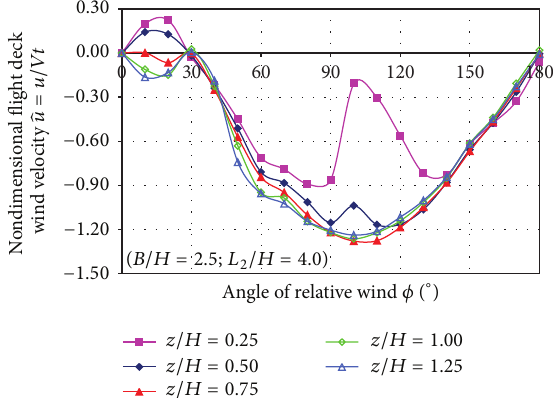
Figure 11: Nondimensional velocity ̂ V as a function of relative wind angle.